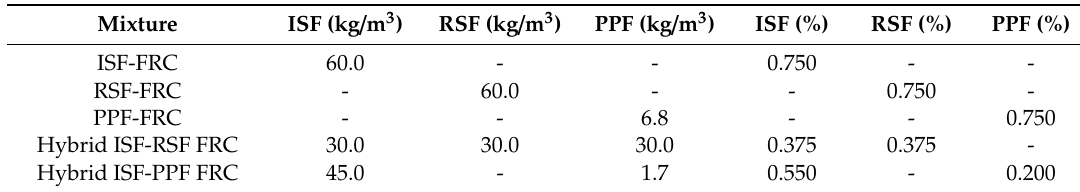
Table 2. Fiber Reinforced Concrete mixtures [37,38].